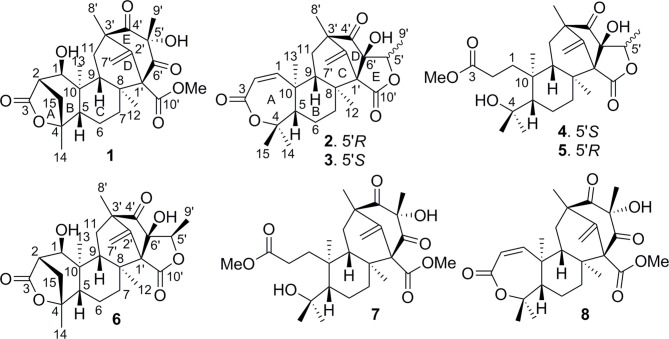
Structures of 1–8.